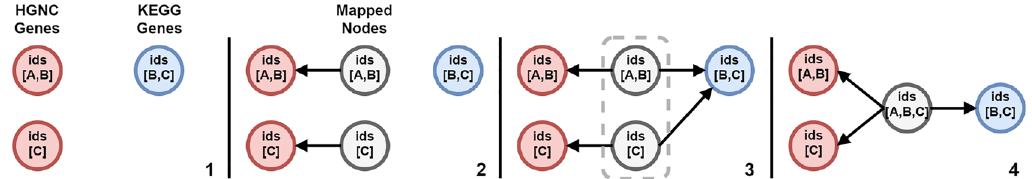
Figure 5: Steps of the node mapping process. (1) The datasources are merged into a single graph. (2) Mapping nodes are created for the first data source and connected with their respective data source nodes. (3) The next data source is mapped resulting in an identifier overlap between two mapping nodes. (4) The overlapping mapping nodes are merged into a singular node.